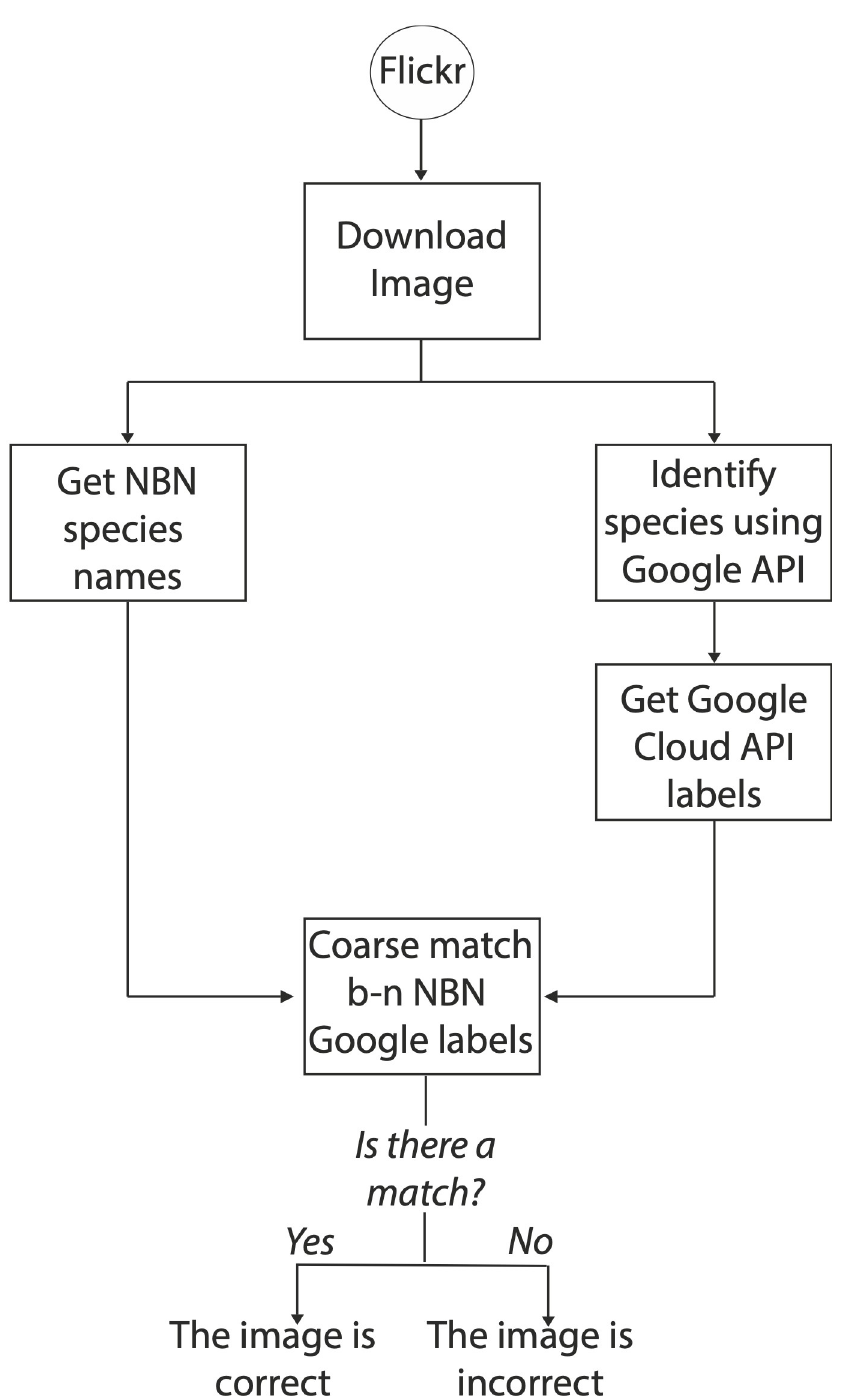
Fig 2. Image validation approach overview—‘b-n’ refers to